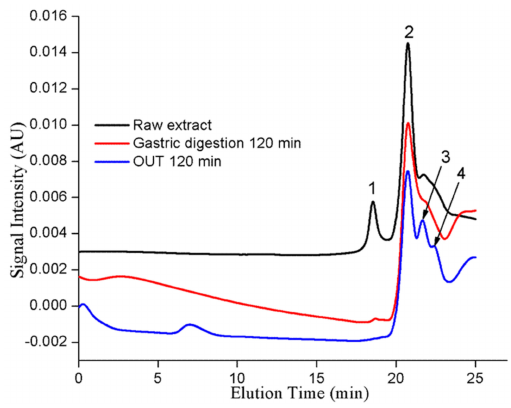
Figure 2. Representative gel permeation chromatograms of the raw extract, gastric digestion at 120 min, and OUT 120 min samples prepared in